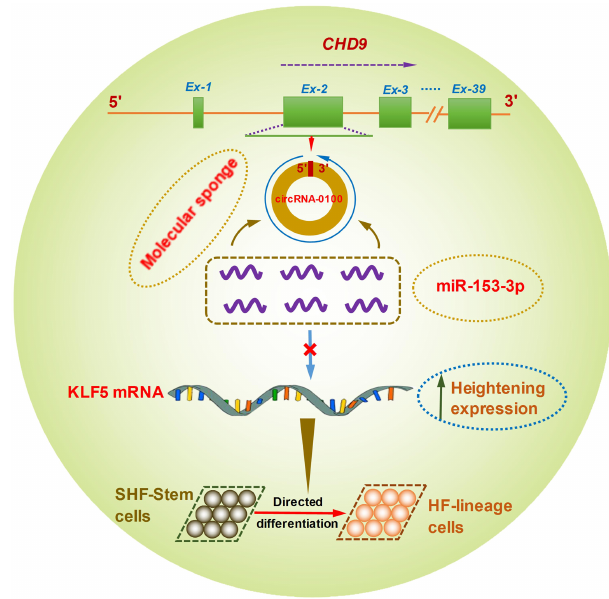
Figure 6. A schematic representation of the functional mechanism of circRNA-0100 in promoting the differentiation of cashmere goat SHF-SCs into hair follicle lineage via sponging miR-153-3p to heighten the KLF5